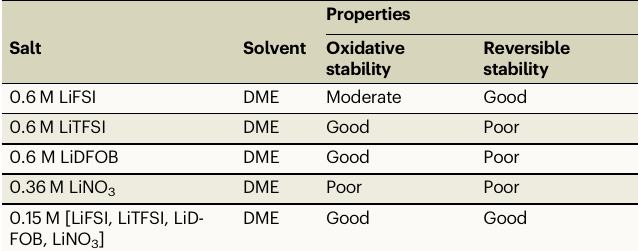
Table 1 | Components used in the HE-DME electrolyte and their stabilities in each single system Properties